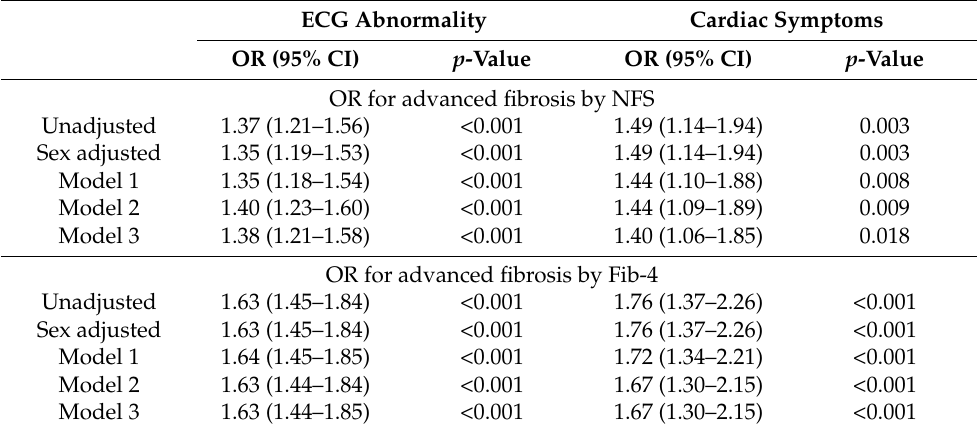
Table 2. Adjusted odds ratios of electrocardiogram abnormalities and the presence of cardiac symp- toms for advanced liver fibrosis defined and identified using the NFS and